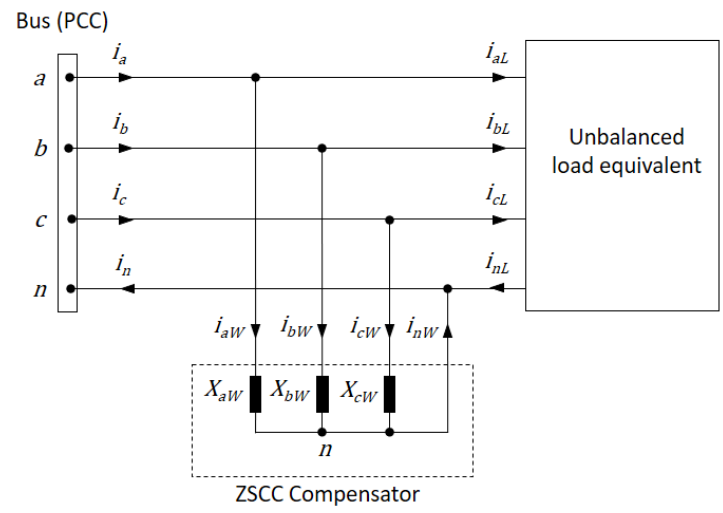
Figure 3. Compensation of zero-sequence currents.